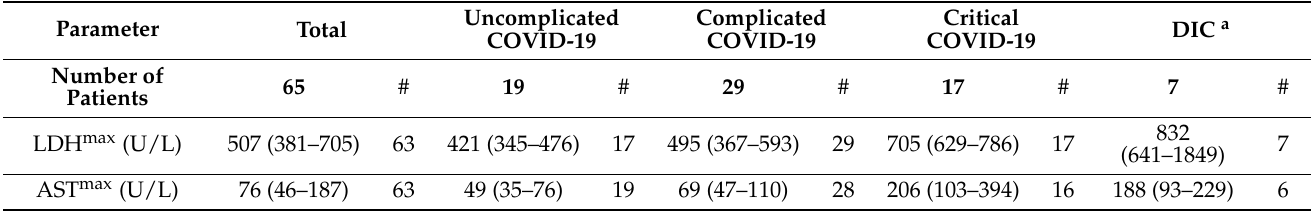
Table 2. Laboratory analyses of 65 patients with COVID-19 analyzed for haemostatic